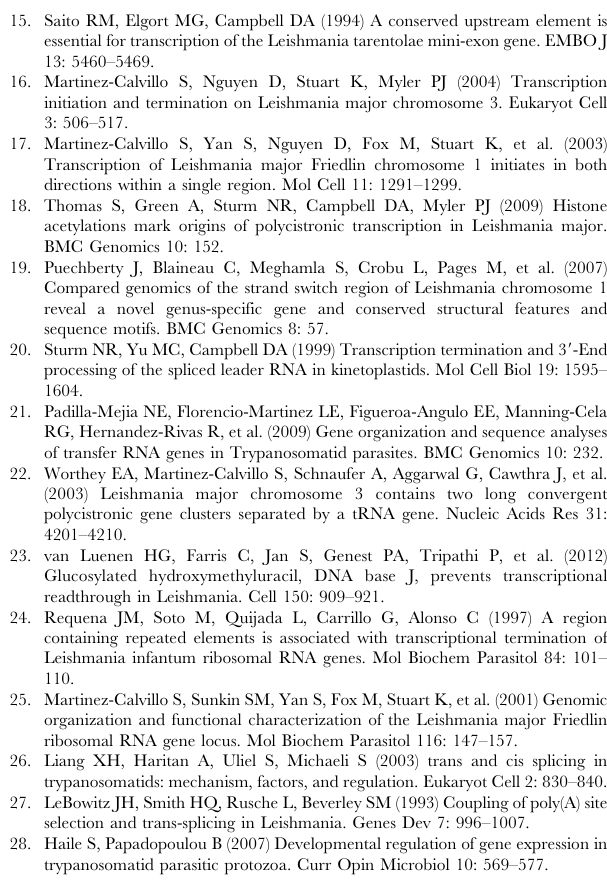
Figure S2 Genome wide curvature distribution for the Tritryps. The DNA intrinsic curvature for the Tritryps genomes L. major ( 2 ), T. brucei (–) and T. cruzi (…), an external reference fragment of approx. 7 Mb from human chromosome 1 spanning from 137 Mb to 144 Mb (–) and E. coli BW2952 strain (–), were analyzed with the bend.it algorithm, using a 31 bp window and DNaseI + nucleosome positioning data parameters. (PDF) Figure S3 Box plots of the intrinsic curvature distribu- tion across Leishmania chromosomes. Chromosomes are depicted in ascending order from left to right. Upper panel: L. major chromosomes 1 to 36. Lower panel: L. infantum chromosomes 0 to 36; L. braziliensis chromosomes 0 to 35; L. mexicana chromosomes 0 to 34 from L. mexicana. For lower panels axes are as in the upper panel. (PDF) Figure S4 Relationship between peaks of high predicted intrinsic curvature and chromosome length. A. The number of IC peaks greater than 9 degrees per helical turn in each chromosome was plotted against the chromosome length. B. The average frequency of IC peaks greater than 9 degrees per helical turn (calculated as the chromosome length divided by the absolute number of peaks) is plotted against chromosome number. (PDF) Figure S5 Graphical representation of IC peaks on all L. major chromosomes. Bar plots of IC positions with an IC value greater than 9 degrees per helical turn. Both DNA strands